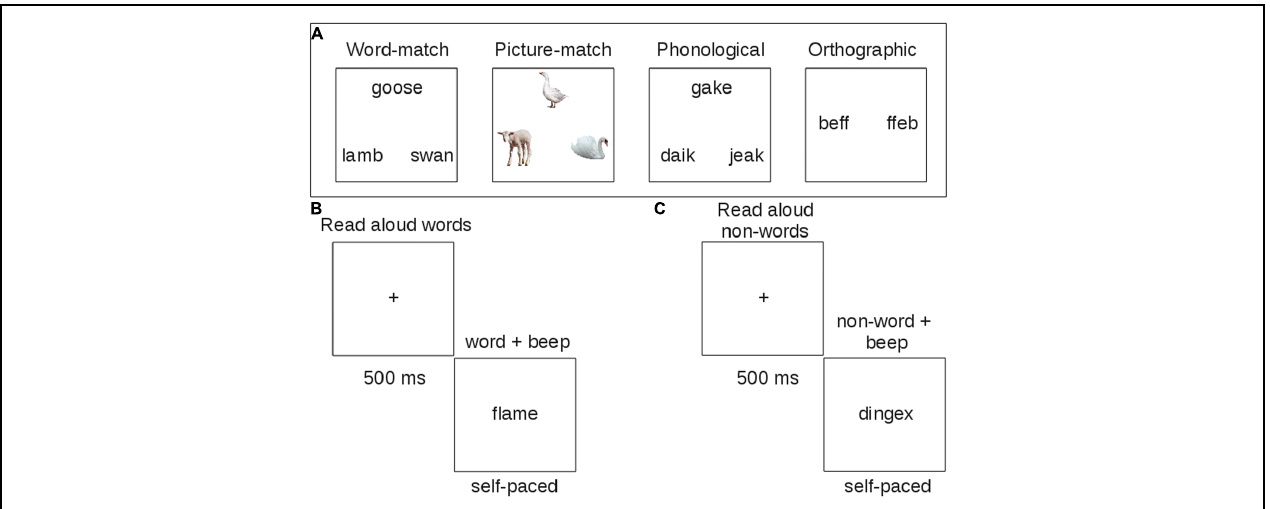
FIGURE 1 | Example trials of behavioral tasks administered to patients. Each task was designed to measure one component of reading. (A) Touch-screen tasks; (B) reading aloud task with words; (C) reading aloud task with non-words.